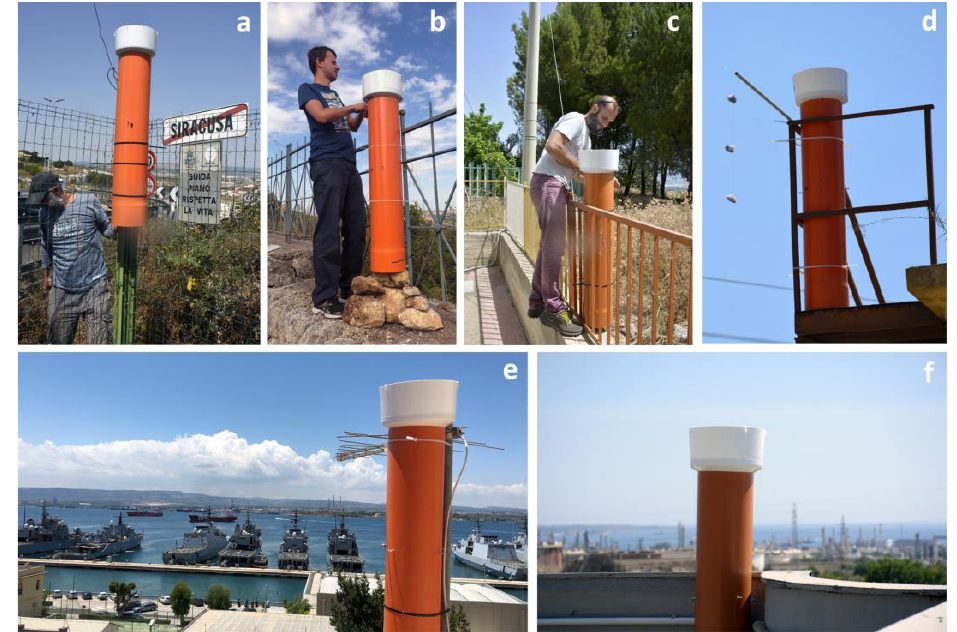
Figure 2. Examples of bulk collector installations. ( a ) Siracusa (Scala Greca); ( b ) Palazzolo Acreide; ( c ) Melilli; ( d ) Archi (Milazzo); ( e ) Augusta; ( f ) Priolo Gargallo.